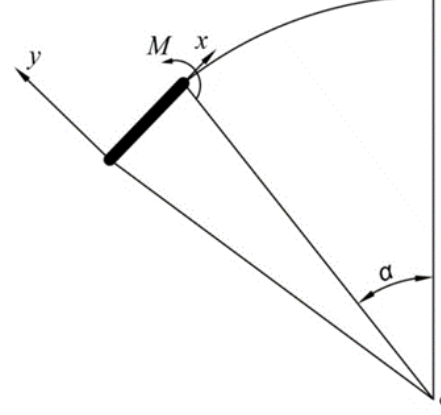
Figure 2. Microelement of the circular lining.